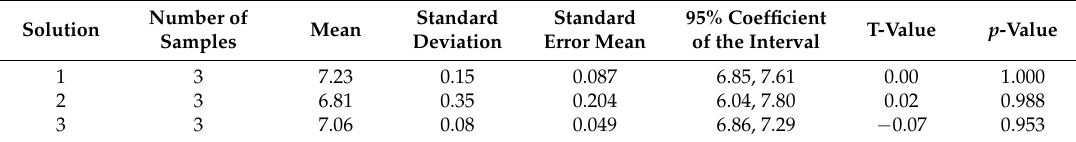
Table 6. T-test table of verification of the model.